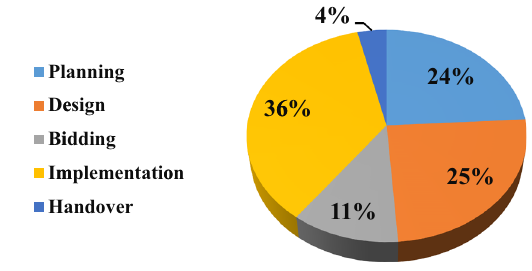
Figure 4: Standard weight% for each